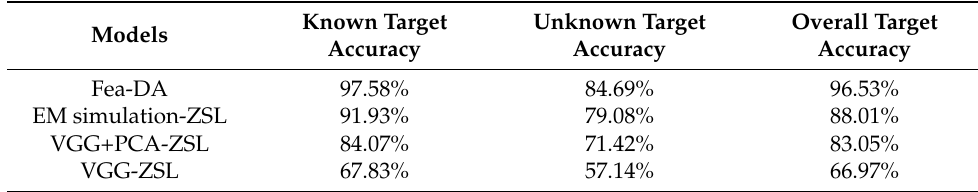
Table 5. Results of 1-type unknown target